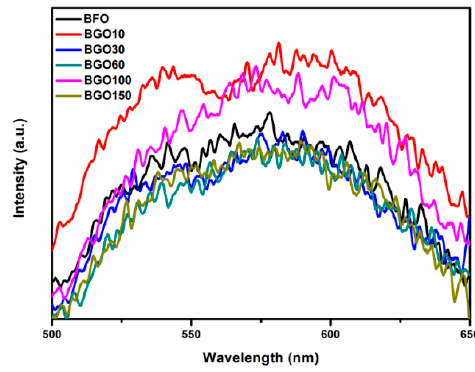
Figure 8. Photoluminescence spectroscopy of BFO and BGO